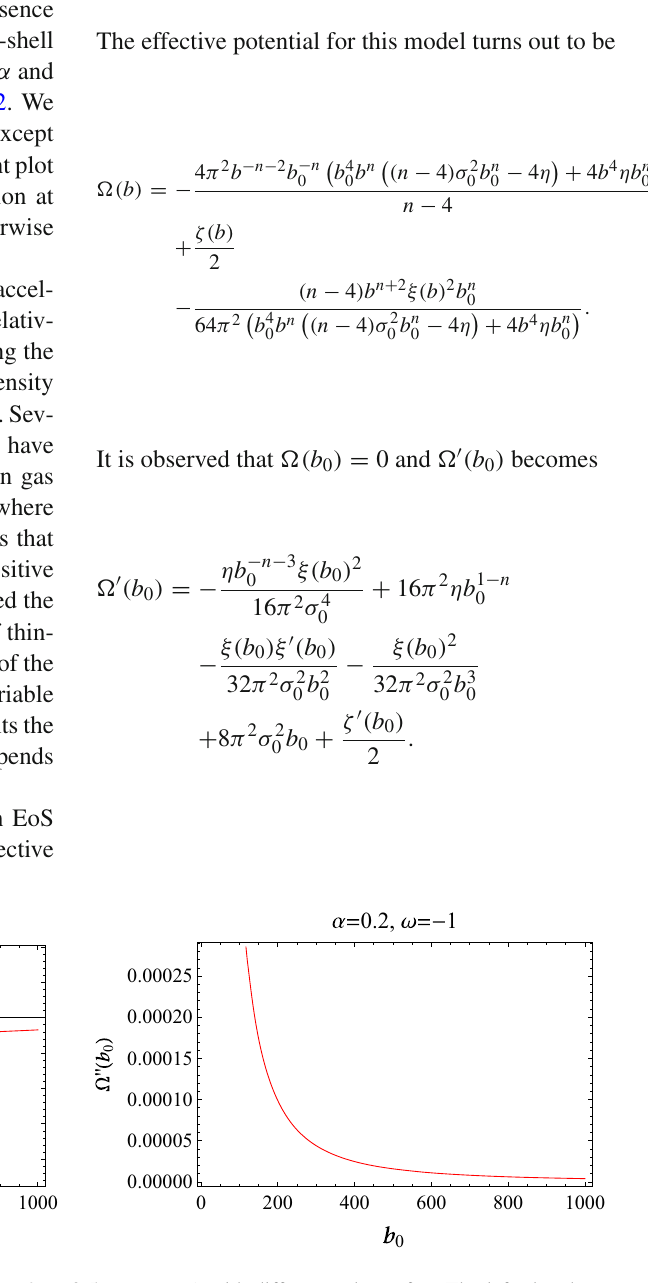
Fig. 2 Stability of thin-shell gravastars with barotropic EoS for β = 0 . 5 = m = Q with different values of ω . The left plot shows unstable behavior and right plot expresses the stable